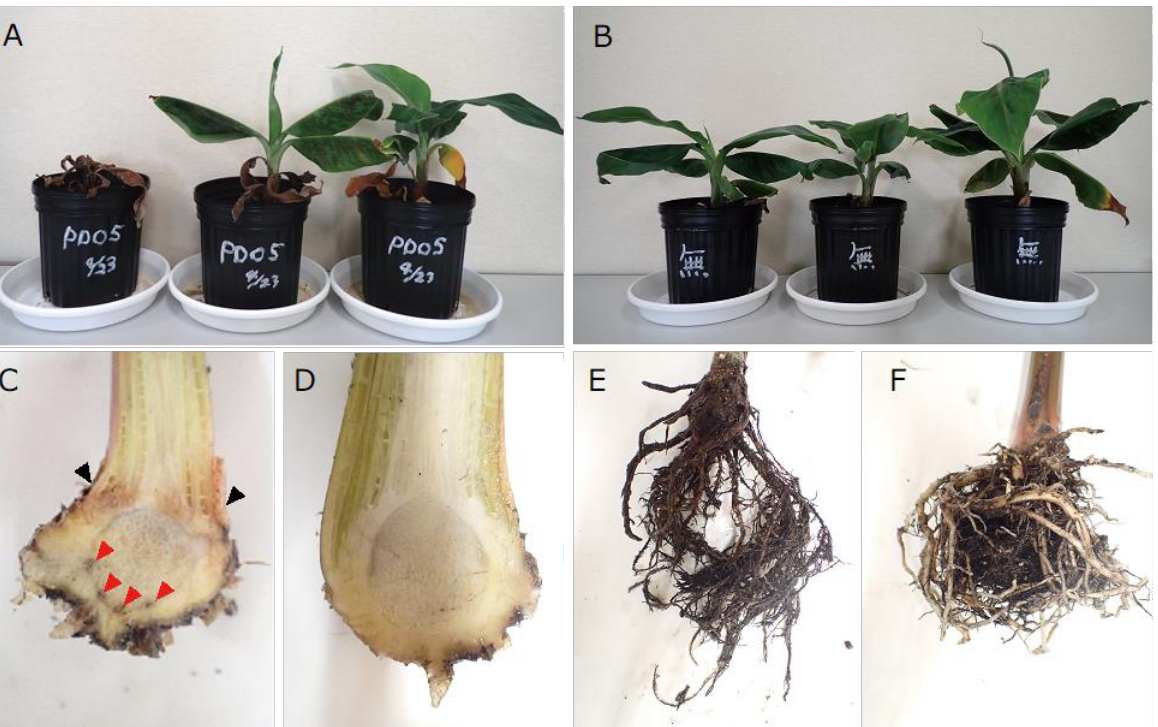
Figure 5. Pathogenicity test of F. mindanaoense PD20-05 using bananas (cv. dwarf Cavendish). ( A ). Wilting symptoms 34 days after inoculation with F. mindanaoense PD20-05. ( B ). Control plants without inoculation with F. mindanaoense PD20-05. ( C ). A tuber of the inoculated plant with blackish tissues (red arrows) and discolored tissues (black arrows). ( D ). A tuber of the control plant. ( E ). The roots of the inoculated plant. ( F ). The roots of the control